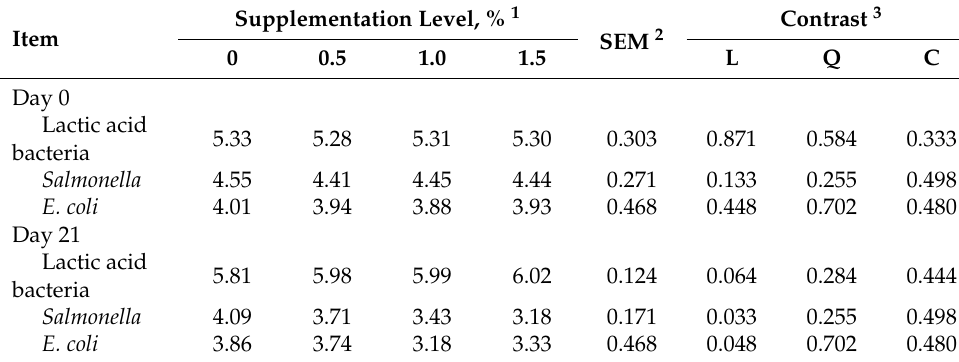
Table 6. Effects of microbial-additive supplementation on the fecal microflora of weaning pigs fed for 21 d (log10